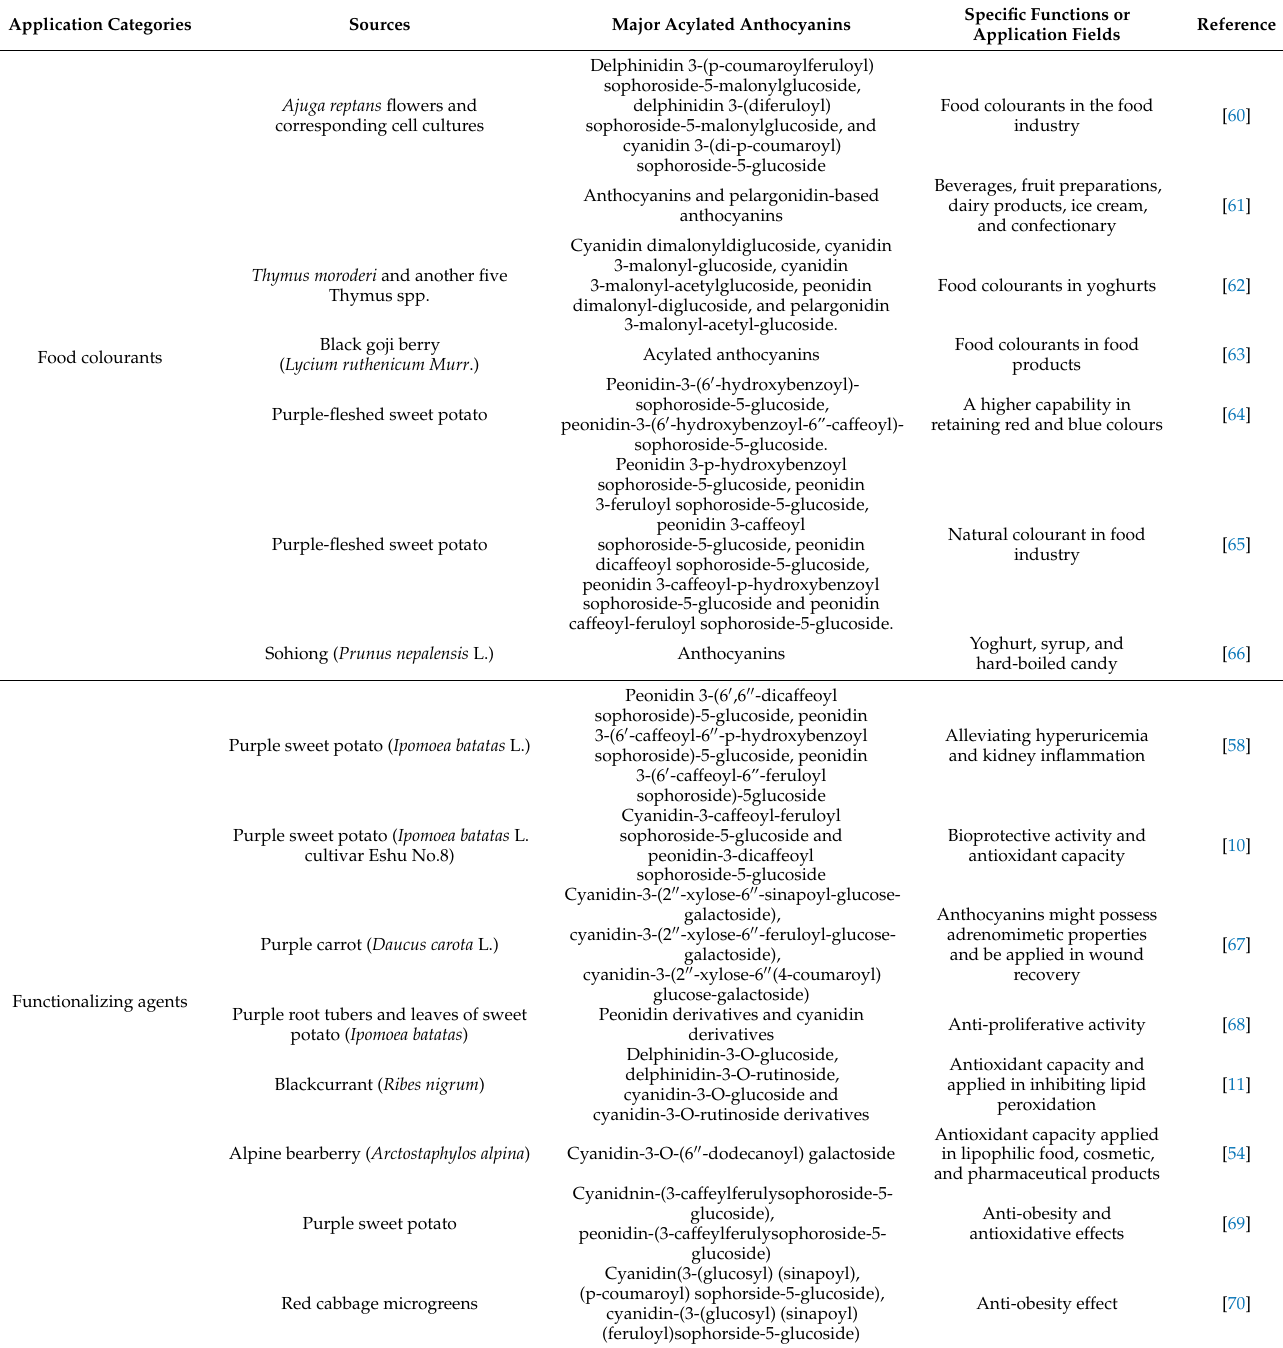
Table 2. Studies on the applications of acylated anthocyanins in the food